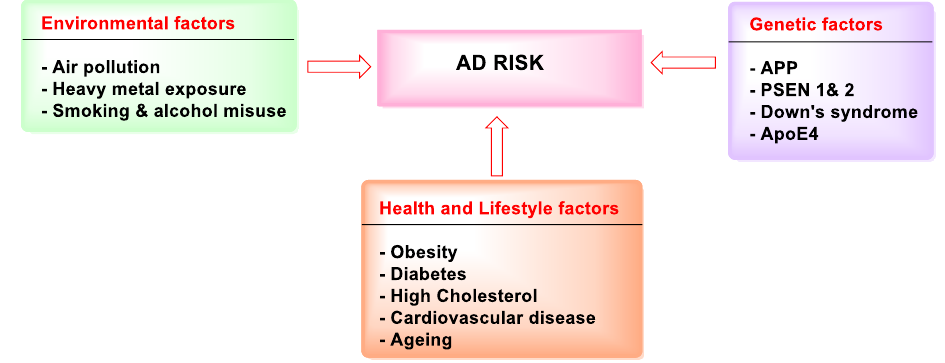
Figure 4. Pl Factors influencing the risk of AD